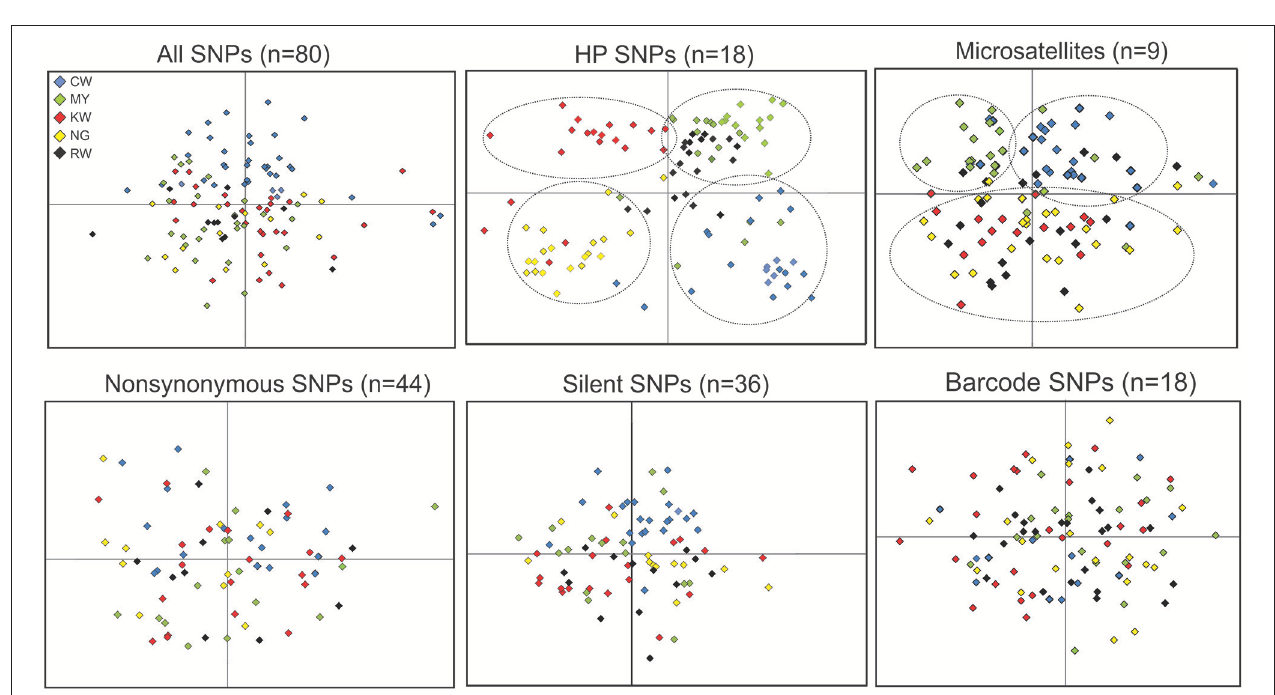
FIGURE 5 | Results of simulation analyses showing the effect of sample size on (A) the numbers of SNPs identified as high-performance and (B) self-assignment rate. (A) The number of SNPs (y-axis) that has F ST ≥ 0.03 (blue line), MAF > 20% (red line), and fits both F ST ≥ 0.03 and MAF > 20% criteria (black line) against sample size (x-axis). Each data point represents the average number of SNPs detected among 10 independent runs and the variance is indicated by error bar. (B) Self-assignment rate (y-axis) against sample size (x-axis) for the different SNP panels and microsatellite markers. Values of mean and standard deviation for each marker set were indicated.